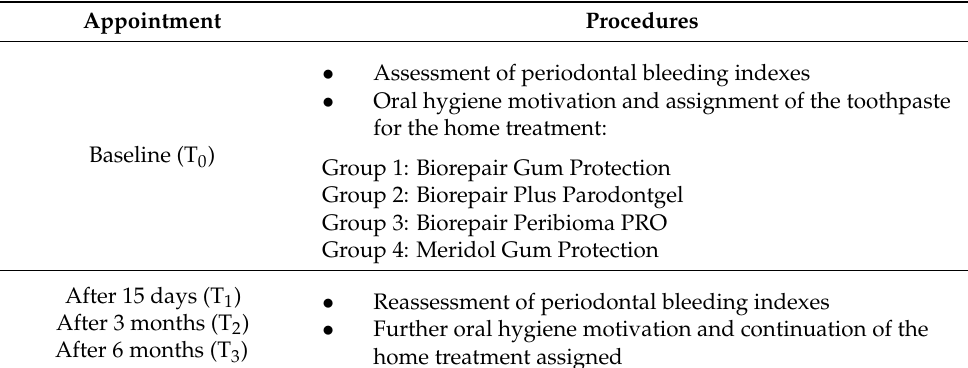
Table 2. Experimental protocol.